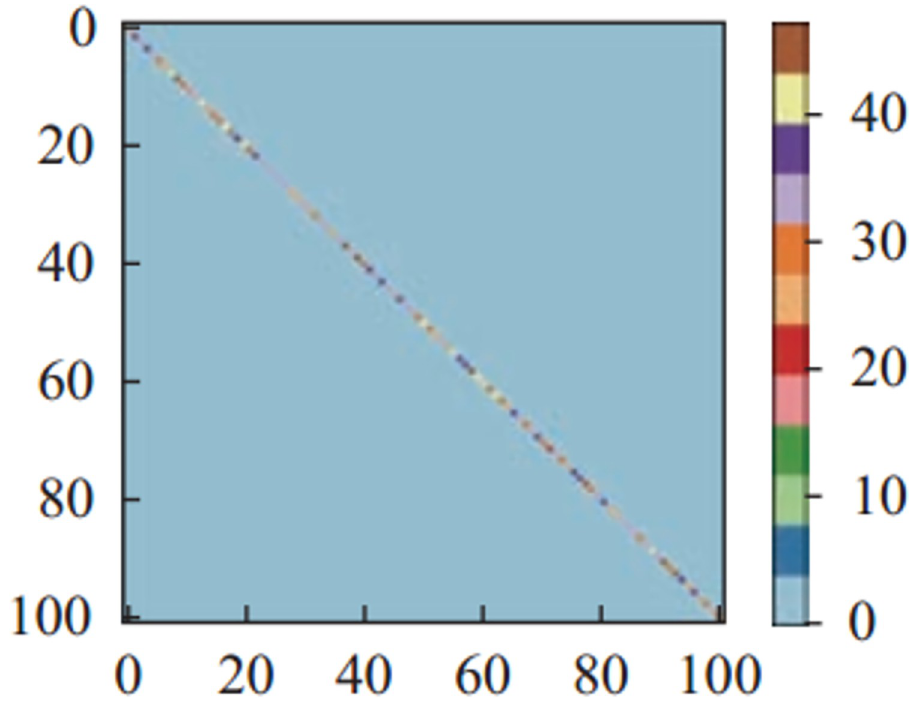
Fig 14. The confusion matrix of the first sectionalization in HMDB-51 under the input warped & original image.